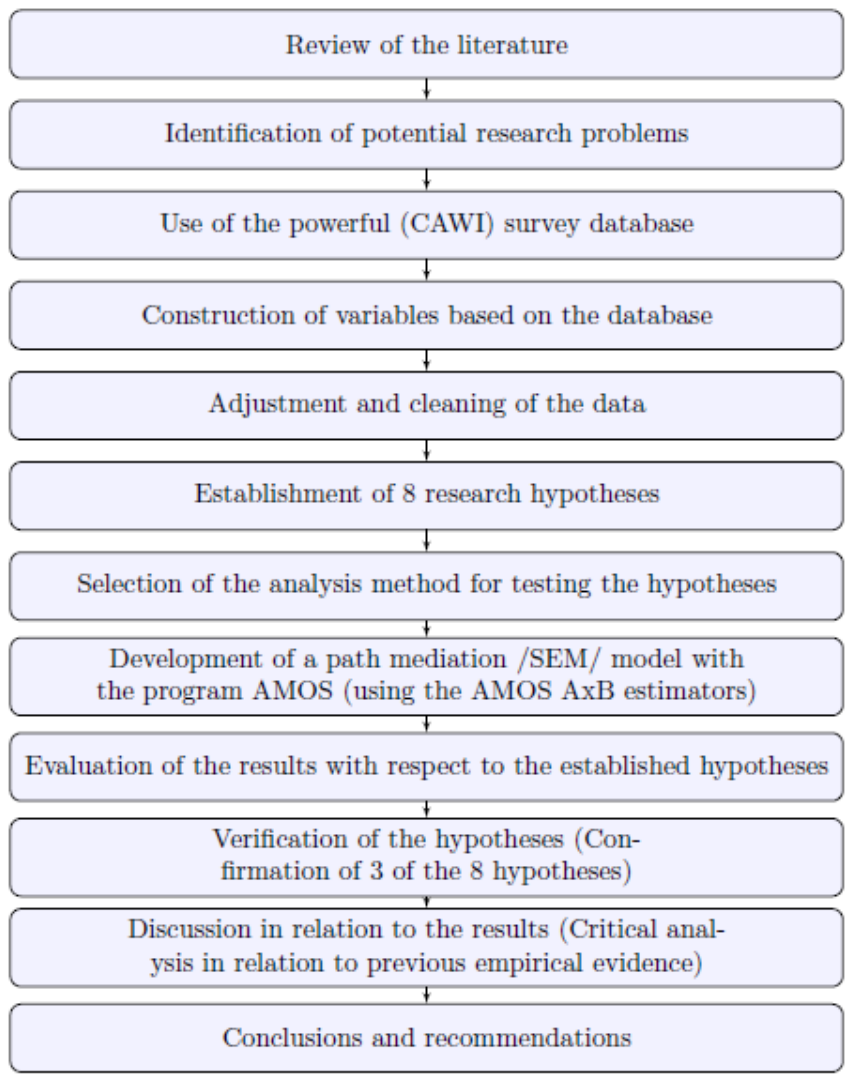
Figure 3. Flowchart of the